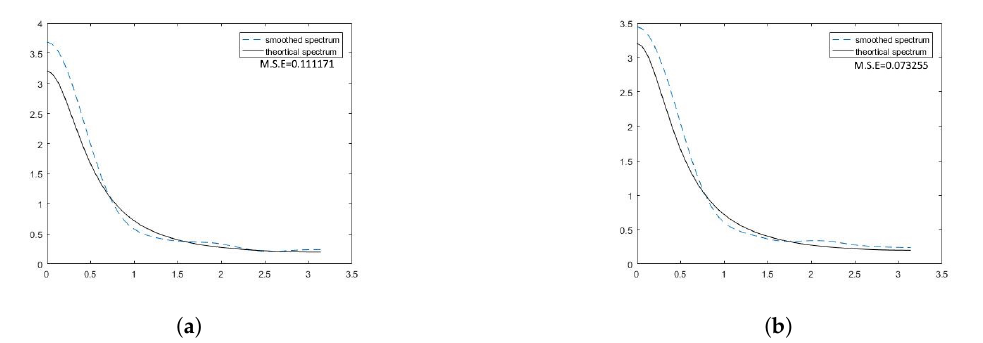
Figure 12. The estimated spectrum using Tukey–Hamming window and the theoretical spectrum. ( a ) Generated observations. ( b ) Forecasted observations.